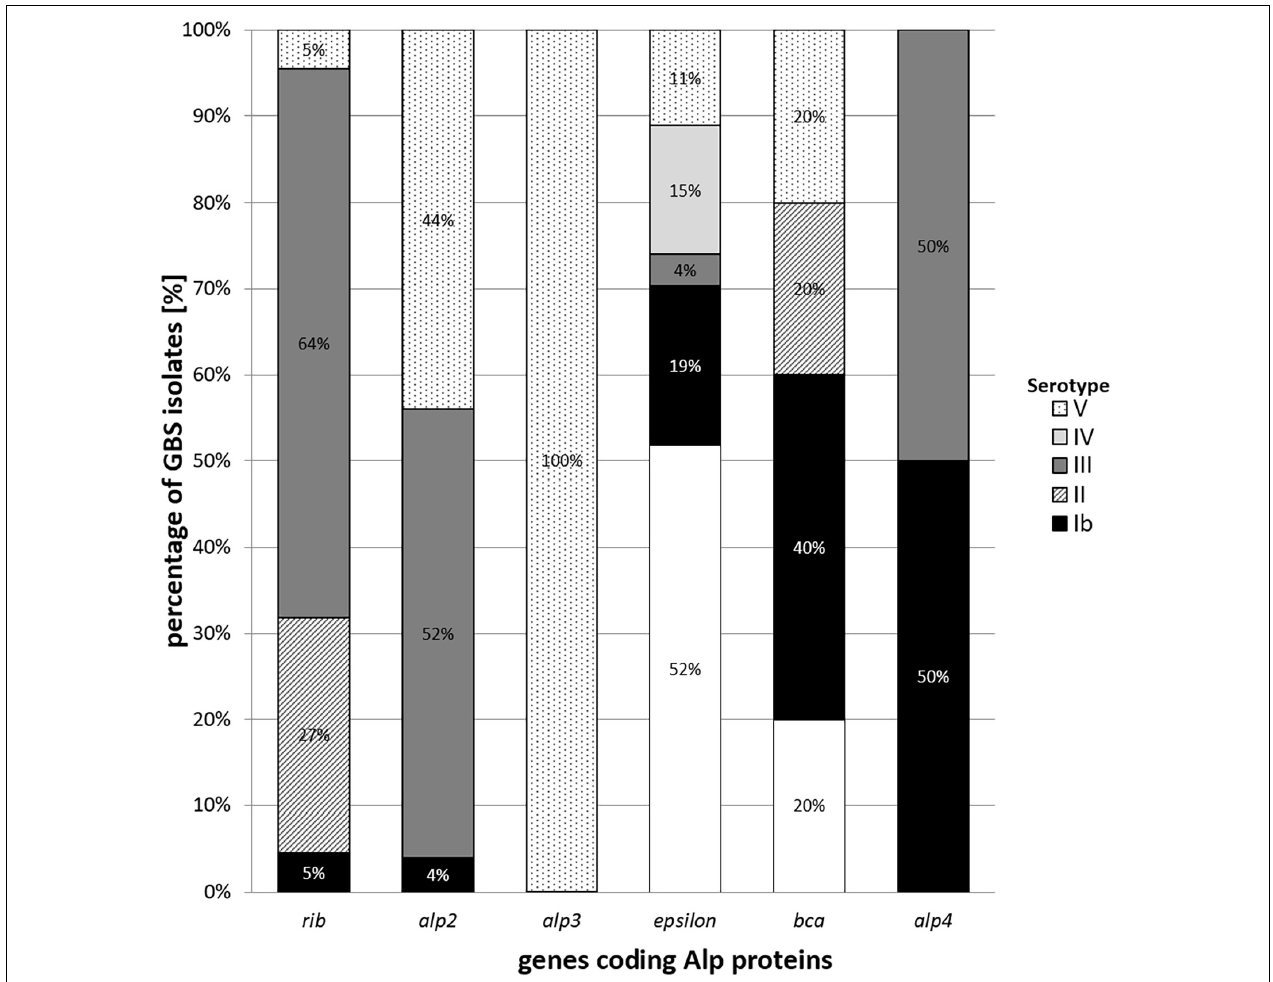
FIGURE 3 | Percentage co-occurrence of various genes coding Alp proteins among Ia, Ib-V serotypes in group B streptococci isolated from